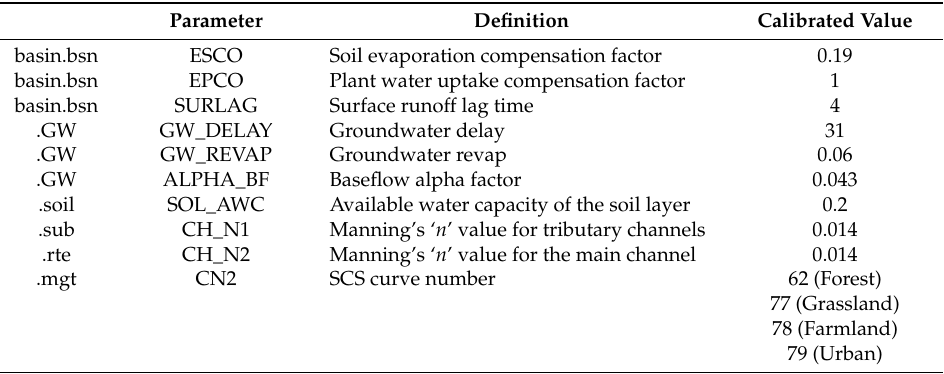
Table 1. Parameters for streamflow calibration of the SWAT in the Upper Honganjian watershed.